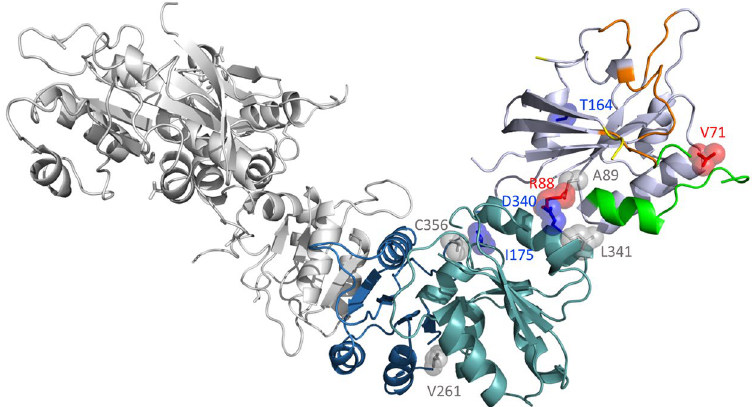
Figure 3. Cartoon representation of HydF monomer structure (PDB ID: 3QQ5). The GTP-binding domain is coloured in light blue violet, the dimerization domain in blue and the cluster-binding domain in teal. The P-loop is highlighted in orange, the terminal parts of sw 1 in yellow and sw 2 in green. The residues that have been mutated and labeled are indicated in the structure and coloured according to the effect on change mobility undergone upon GTP binding and detected by EPR (red, blue and grey, going from high to low effect). Positions S35, S38 and T44 are not highlighted, as they were not resolved in the crystallographic